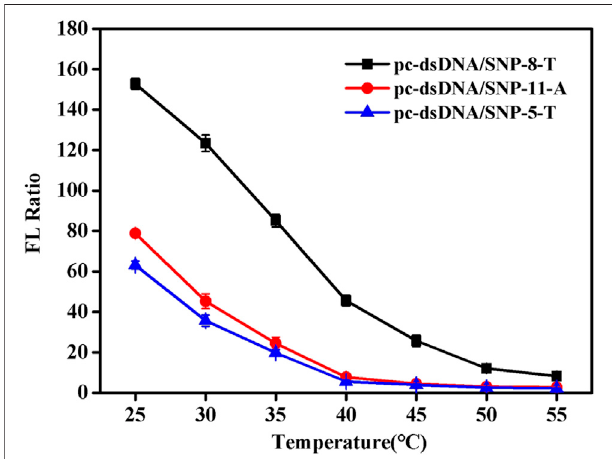
FIGURE 4 | Fluorescence spectra of SG/pc-dsDNA in the presence of various concentrations of pcDNA (0, 0.5, 1, 2, 4, 6, 8, 10, 12, and 15 nM, and the total target DNA containing probe and pcDNA was 20 nM). Other conditions were same as Figure 1